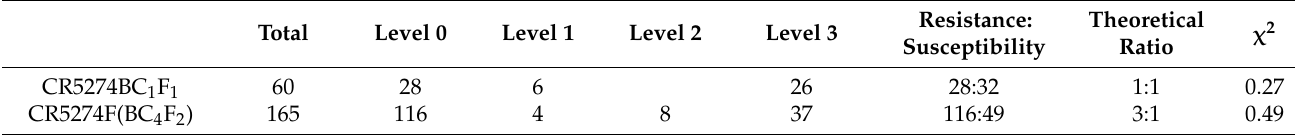
Table 3. Disease resistance of various generations of CR5274.